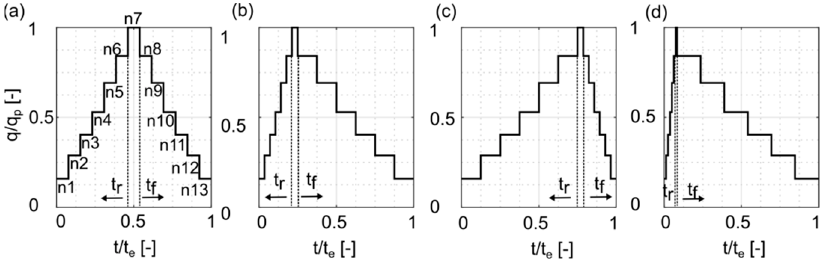
Figure 5. Laboratory hydrographs and indication of discharge intervals (n) and duration of rising limb (t r ) and falling limb (t f ): ( a ) symmetrical, ( b ) positively skewed, ( c ) negatively skewed, and ( d ) flash flood. ( d ) flash